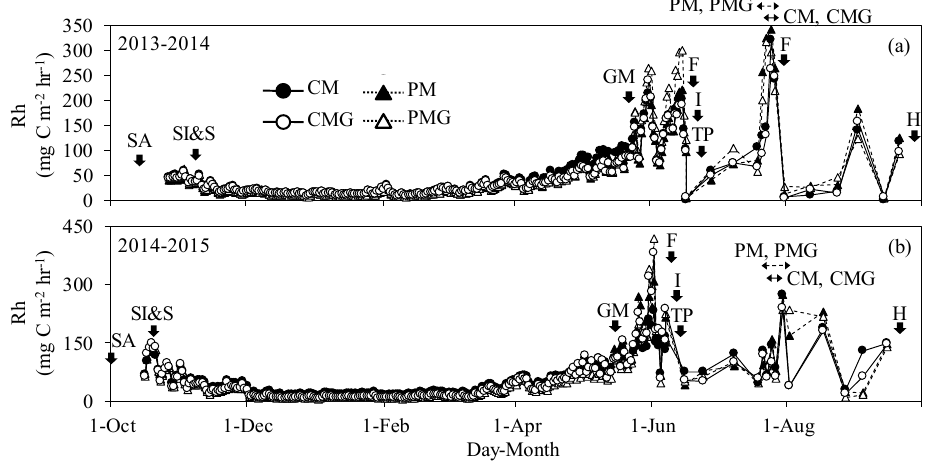
Figure 3. Seasonal variations in heterotrophic respiration (Rh) in the first ( a ) and second ( b ) years Error bars represent standard deviations. SA, SI, and S represent straw application, incorporation, and seeding, respectively. GM, I, F, TP, and H represent green manure and weeds incorporations, irrigation, fertilization, transplanting, and harvest, respectively. Arrows of the continuous and dotted lines show the periods of mid-season drainage.